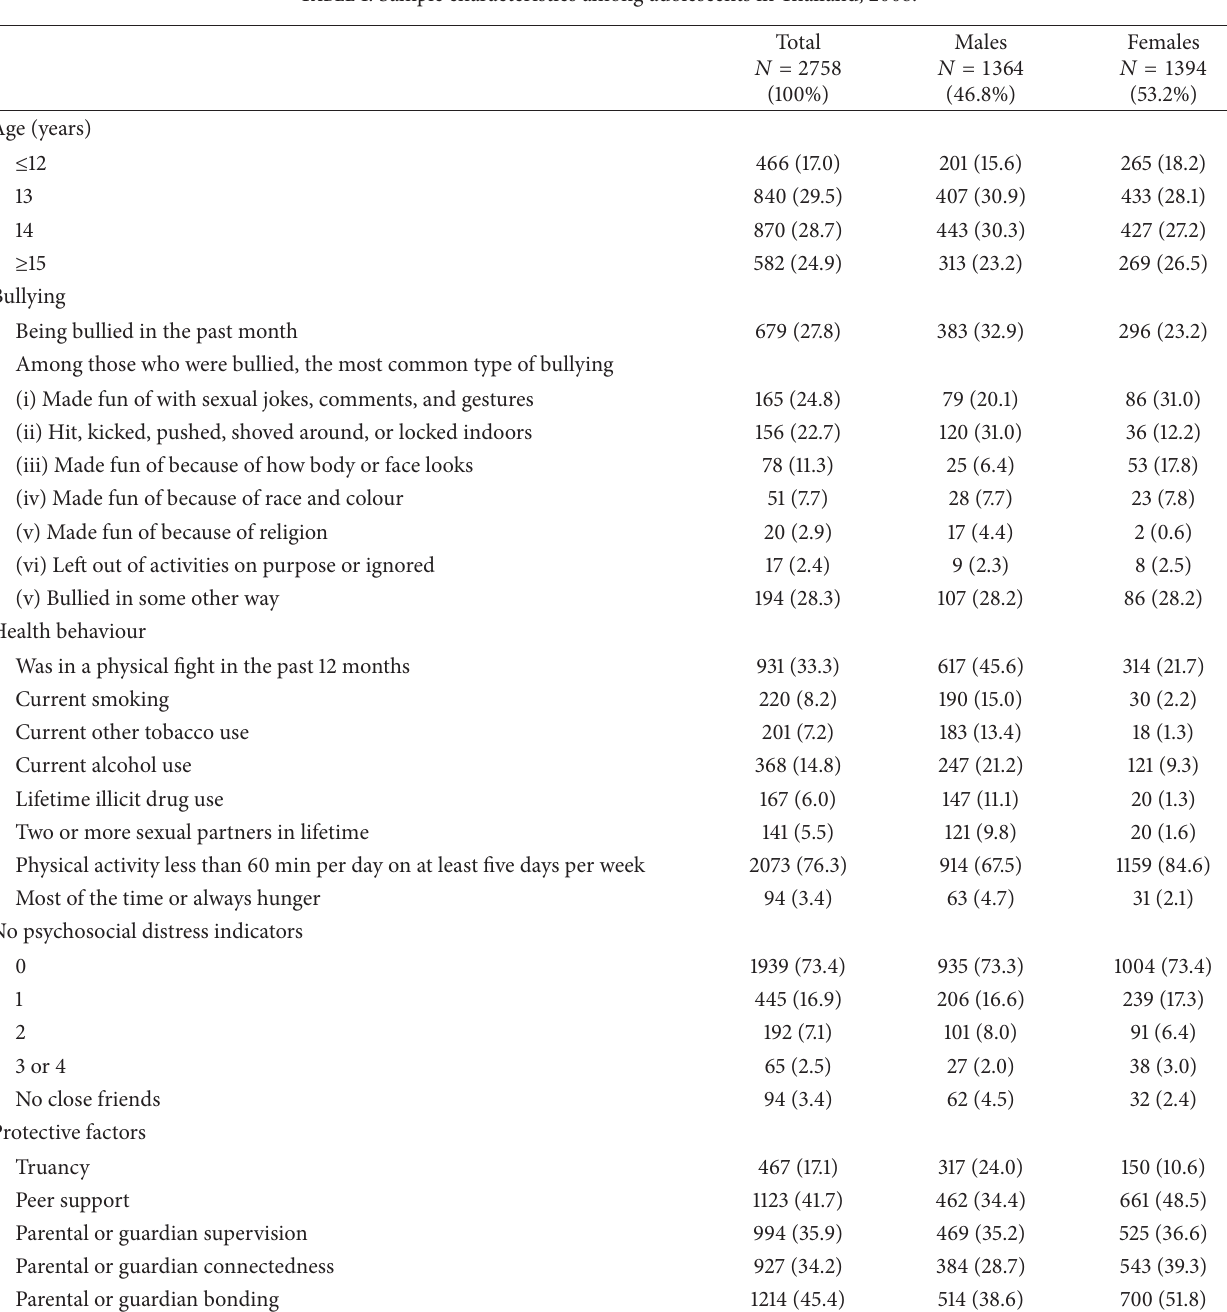
Table 1: Sample characteristics among adolescents in Thailand,